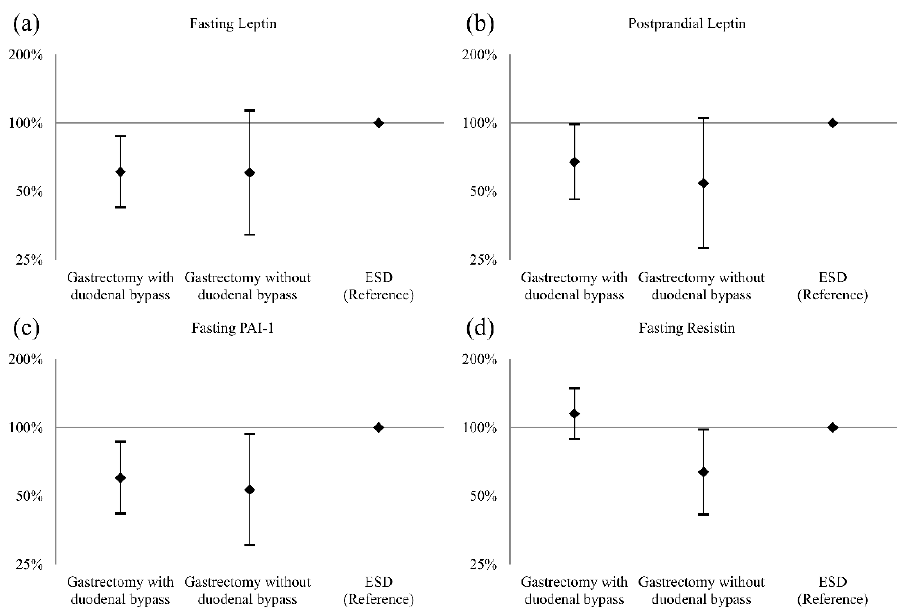
Figure 2. The ratios of metabolic hormone and adipokine levels after gastrectomy and after ESD (the reference). ( a ) Fasting leptin, ( b ) postprandial leptin, ( c ) fasting PAI-1, and ( d ) fasting resistin. The ratios and 95% confidence intervals were estimated using linear mixed models for log-transformed hormone levels, with adjustments for age, sex, time from the baseline, and the baseline measurements of each assessed variable. ESD, endoscopic submucosal dissection; PAI-1, plasminogen activator inhibitor-1.